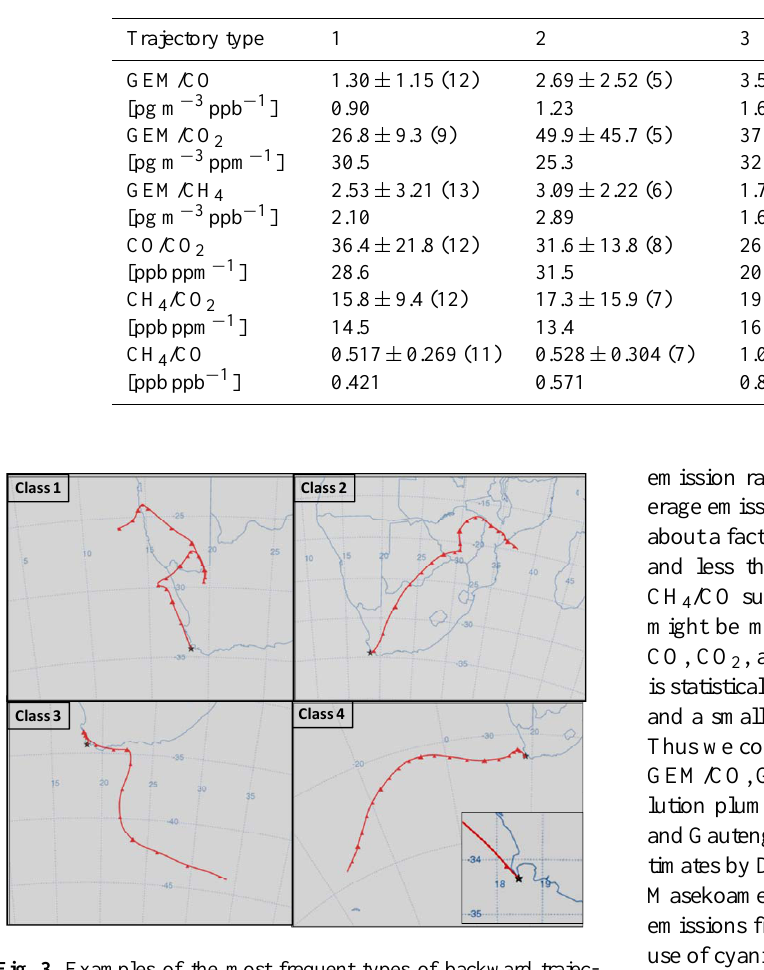
Table 2. Average and median slopes of GEM/CO, GEM/CO 2 , GEM/CH 4 , CO/CO 2 , CH 4 /CO 2 , and CH 4 /CO for different trajectory types. Average, standard deviation and number of slopes are given in the upper line, medians in the lower line.